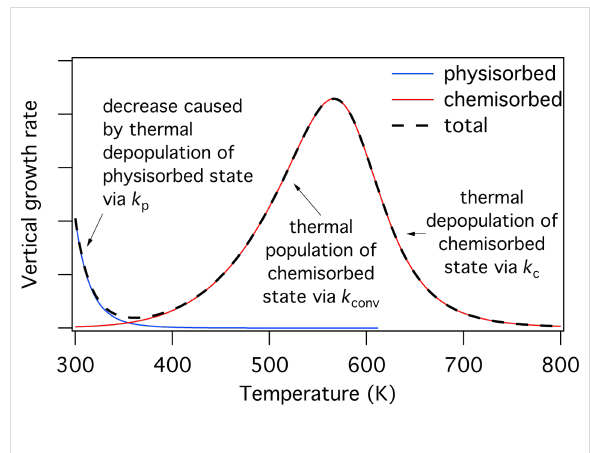
Figure 14: Steady-state vertical growth rate versus substrate tempera- ture for a precursor that undergoes activated chemisorption described by the potential energy digram shown in Figure 12. The blue and red curves show contributions arising from electron induced dissociation of physisorbed and chemisorbed adsorbates, respectively. Modified from